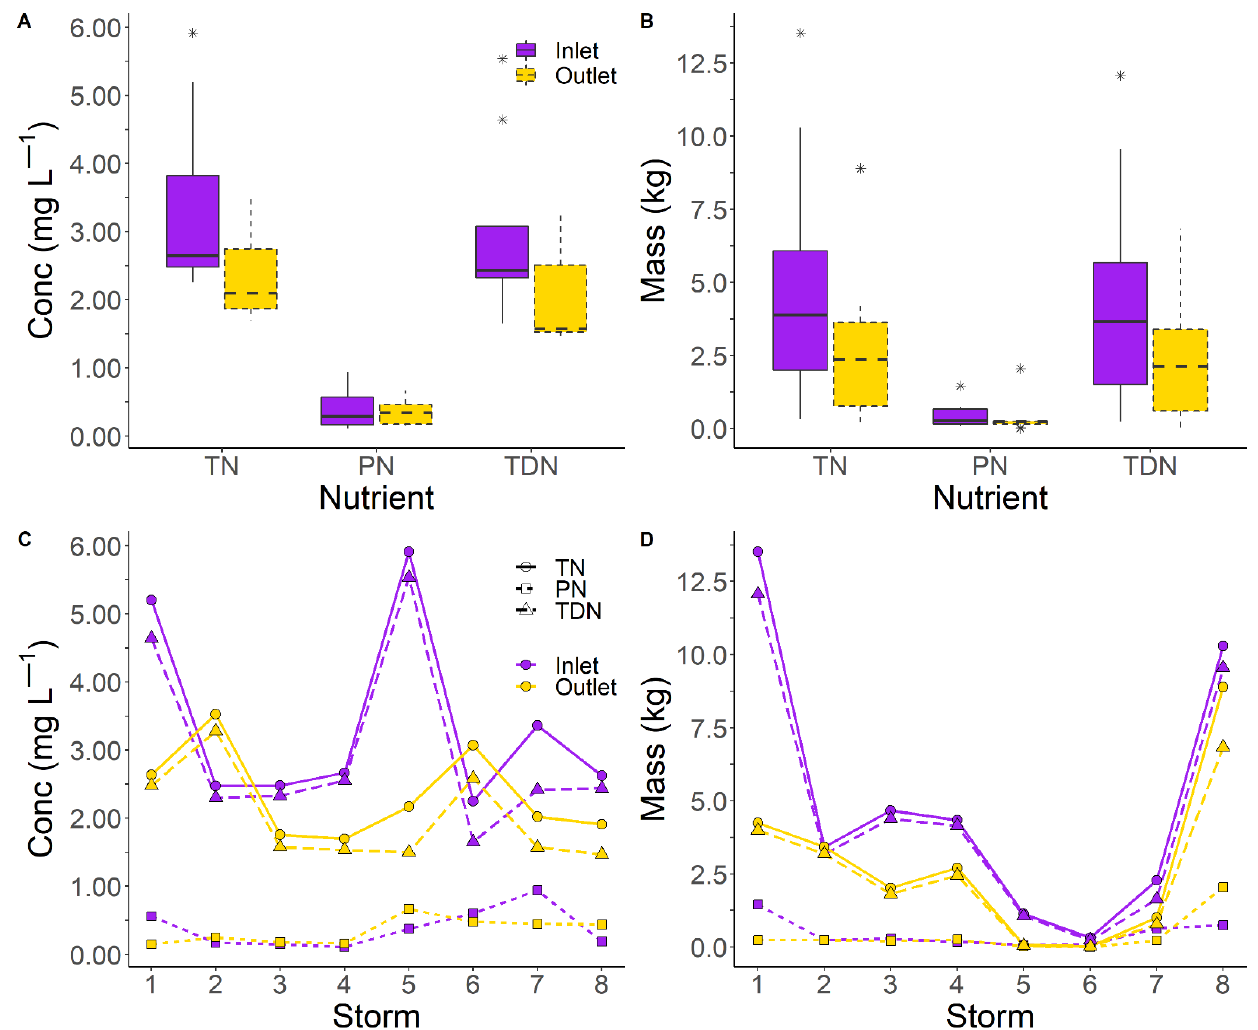
Figure 6. Box plots of event mean concentrations ( A ) and mass loadings ( B ) of total nitrogen (TN), particulate nitrogen (PN), and total dissolved nitrogen (TDN) ( A , C ). Time series of event mean concentrations ( C ) and mass loadings ( D ) of TN, PN, and TDN. Statistical outliers are shown as (*).